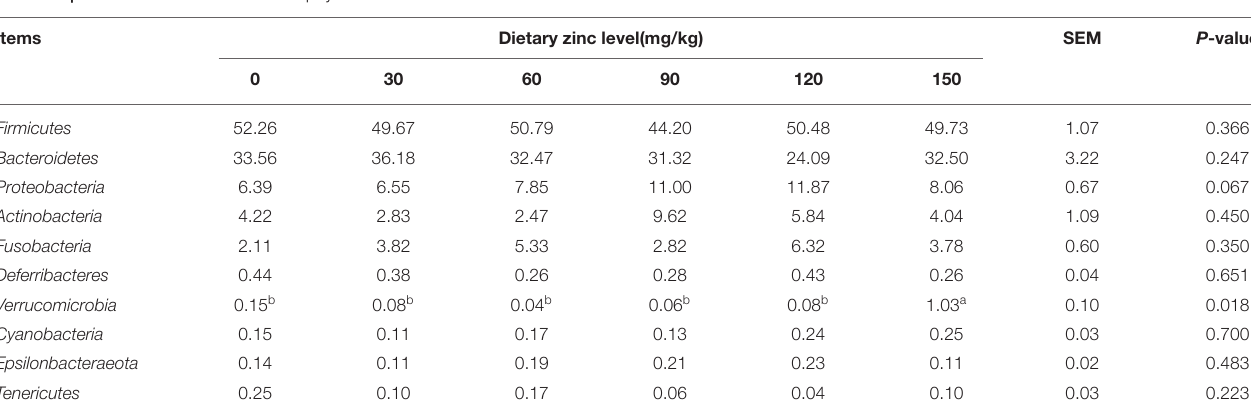
TABLE 9 | The relative abundance at the phylum level of cecal